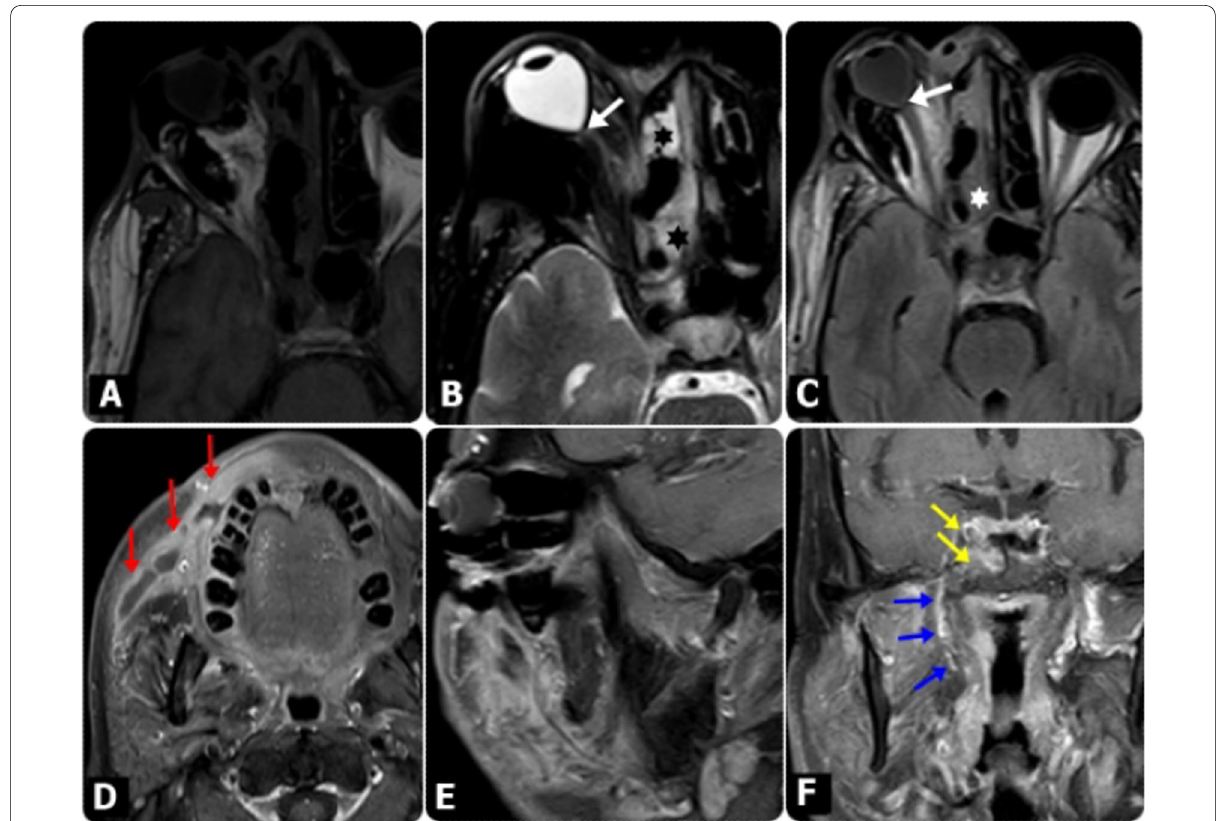
Fig. 5 MRI findings in diabetic male patient, 49 years old, presented mainly with Rt. eye proptosis and Rt. premaxillary and periorbital edema, following COVID‑19. A Axial T1W, B Axial T2‑SPIR and C Axial FLAIR images showed ethmoidal sinusitis (Asterisks), more evident at the Rt. side, with extension of the inflammatory process to the Rt. orbit resulting in proptosis of Rt. eye globe, with posterior globe tenting (White arrows), as well as Rt. periorbital and eyelids edema. D Axial and E Sagittal post‑contrast fat‑saturated T1WI showed extension of the inflammatory process to the Rt. premaxillary region resulting in soft tissue edema and to the Rt. maxillary and zygomatic bones, showing heterogeneous post‑contrast enhancement in keeping with bony invasion (red arrows). The edema and inflammatory process seen extending to the Rt. retro‑maxillary region showing mild soft tissue contrast enhancement. F Coronal post‑contrast fat‑saturated T1WI showing mild enlarged right cavernous sinus with patchy heterogeneous enhancement (yellow arrows), with inflammatory spread to the Rt. infra‑temporal fossa region (blue